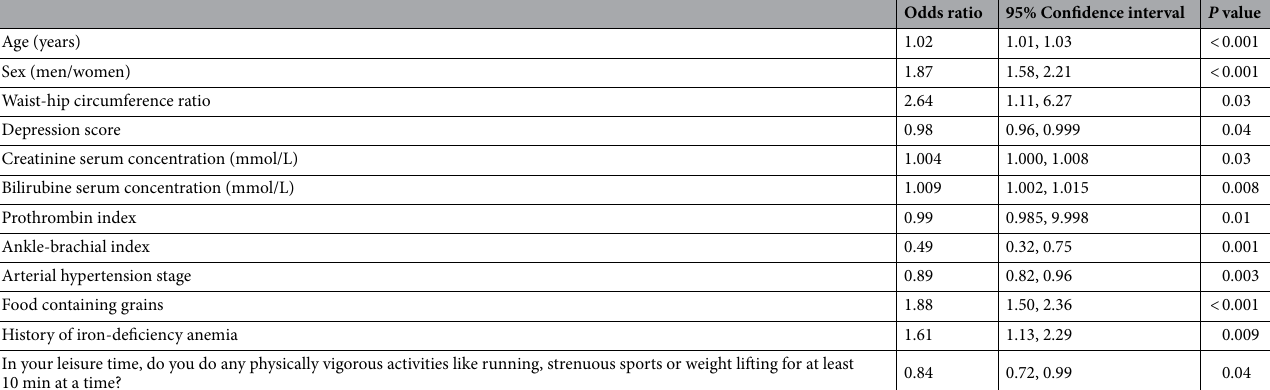
Table 2. Associations (multivariable analysis) between the prevalence of non-alcoholic fatty liver disease (NAFLD) and other parameters in the Ural Eye and Medical Study.